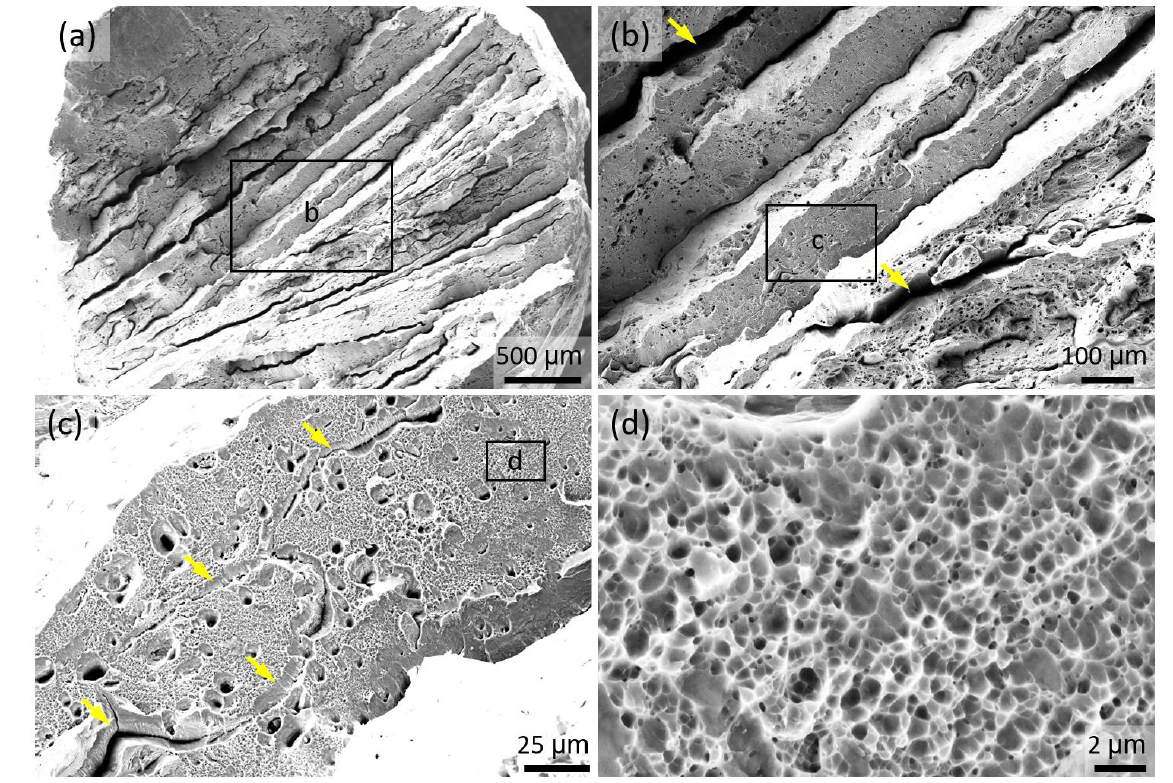
Figure 12. Fracture surface of 3Al steel at different magnifications. ( a ) Overview of the fracture surface; ( b – d ) magnified view of the regions marked by rectangles, see the label within each rectangle to locate. Arrows in ( b , c ) indicate decohesion along grain and subgrain boundaries, respectively. ( d ) provides a magnified view of dimples in the austenite.